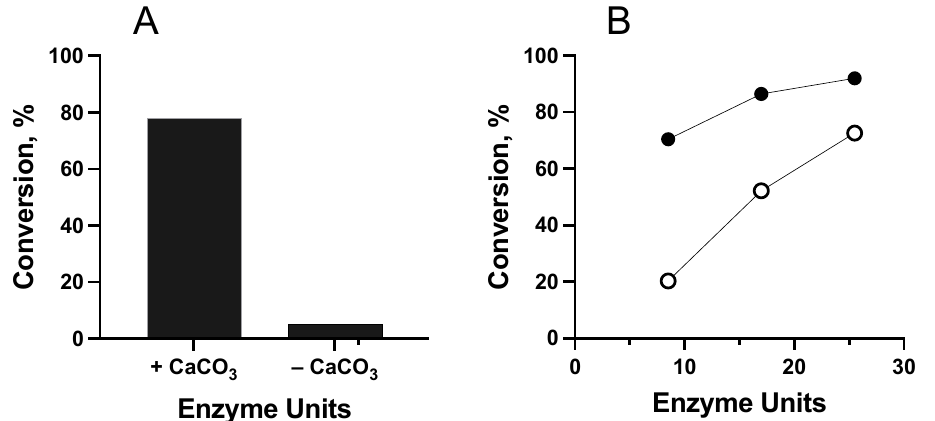
Figure 7. Conversion yield for the enzymatic acetylation of phenylethanol in a biphasic system. Phenylethanol, 30 mg; vinyl acetate:phosphate (2:1); temperature, 65 °C. ( A ) Conversion obtained after 24 h reaction with 8.5 U of KLEST-3S in the absence or the presence of 100 mg CaCO 3 . ( B ) Conversion yield at three enzyme concentrations (8.5, 17 and 25.5 U), after 5 h (open circles) or 24 h reaction time (closed circles).